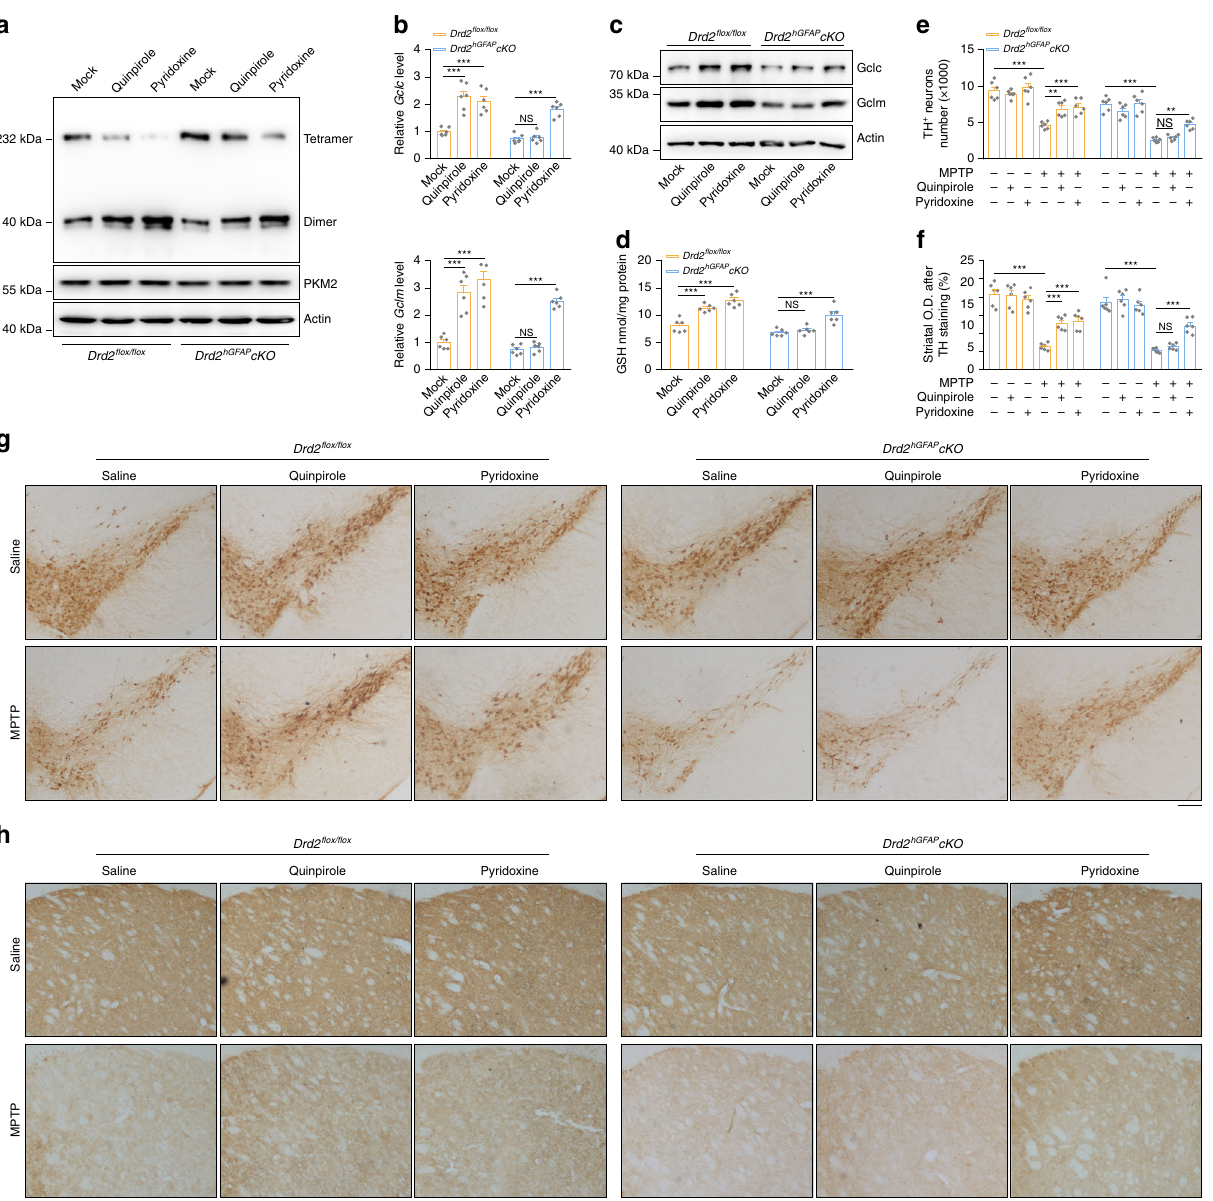
Fig. 6 Pyridoxine reduces dopaminergic neuron loss in the PD mouse model. a – d Drd2 fl ox/ fl ox and Drd2 hGFAP cKO mice were sacri fi ced after continuous infusion of 5 mg kg − 1 quinpirole or 5 mg kg − 1 pyridoxine for 7 consecutive days, and the striatum was dissected for further analysis. PKM2 dimer and tetramer formation analyzed by BN-PAGE and total PKM2 detected by immunoblotting with actin as a loading control ( a ). Gclc and Gclm mRNA detected by qRT-PCR ( b ). Immunoblotting with actin as a loading control ( c ) and GSH levels ( d ). Immunoblotting and qRT-PCR: three independent experiments; GSH assay: six independent experiments. e – h Drd2 fl ox/ fl ox and Drd2 hGFAP cKO mice were used to generate an MPTP-induced PD mouse model (20 mg kg − 1 i.h., 5 d ), which was treated by continuous infusion of quinpirole (5 mg kg − 1 i.p.) or pyridoxine (5 mg kg − 1 i.p.). Quanti fi cation of TH + neurons ( e ). Striatal optical density (O.D.) measurements of TH-stained slices ( f ). Immunohistochemical staining of TH + neurons ( g ). Immunohistochemical staining of TH in the nigrostriatal system ( h ). n = 6 mice per group. Scale bar, 200 µ m. Data are presented as the mean ± s.e.m. ** P < 0.01, *** P < 0.001, NS, not signi fi cant. Two-way ANOVA with Dunnett ’ s multiple comparisons test ( b , d ) or with Tukey ’ s multiple comparisons test ( e , f ). Source data are provided as a Source Data fi